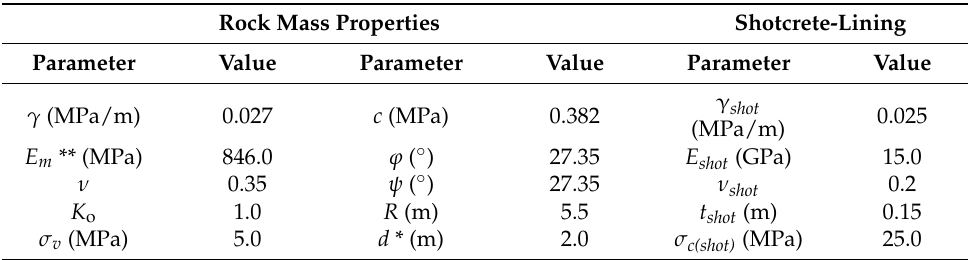
Table 5. Input data of the numerical computation of ICM and Gschwandtner-Galler (2012) [26]. Rock Mass